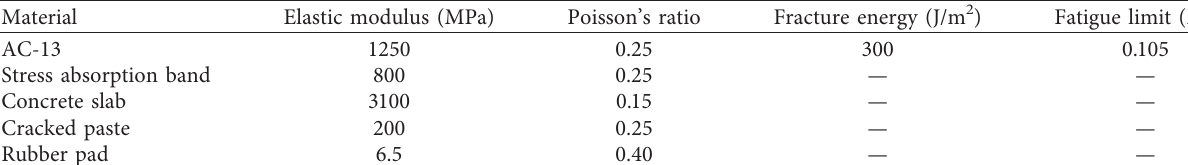
Figure 5: Meshing of the structure via the XFEM. (a) 2D model. (b) 3D model. Table 3: Mechanical properties of the constituent materials of the employed model.